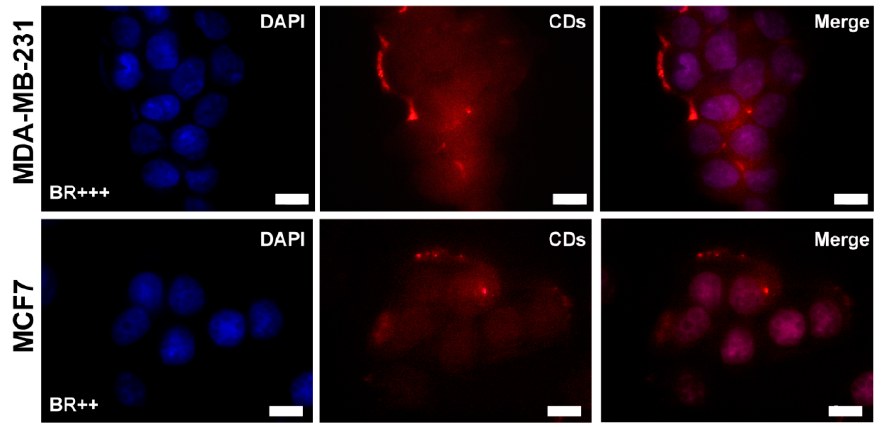
Figure 5. Cell uptake by fluorescence microscopy on MDA-MB-231 and MCF7 cell lines incubated for 4 h with CDs-PEG-BT (100 µg mL − 1 ). Scale bar: 10 µm (100× magnification). Nuclei (DAPI channel— blue ), CDs-PEG-BT (Txr channel— red ).